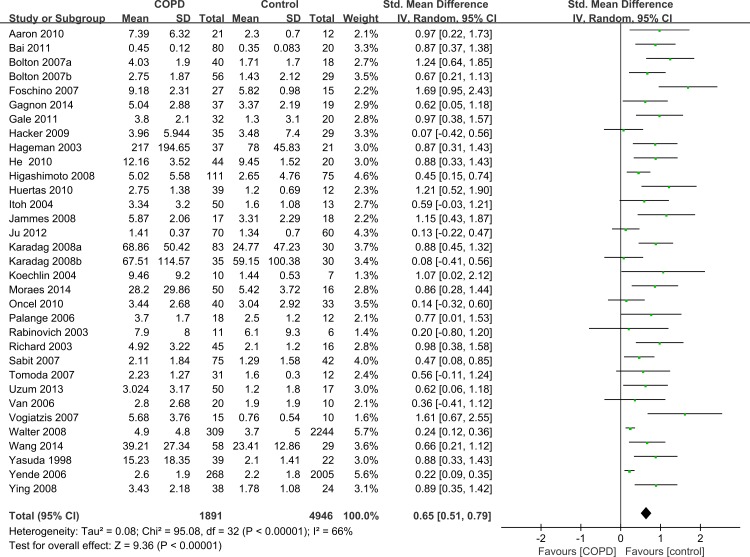
Forest plot for the association between serum IL-6 concentrations and COPD.Forrest plot of meta-analysis of 33 studies that investigated the association between serum IL-6 concentrations and COPD, using a random-effects model. COPD, chronic obstructive pulmonary disease; SD, standard difference; SMD, standard mean difference; CI, confidence interval.